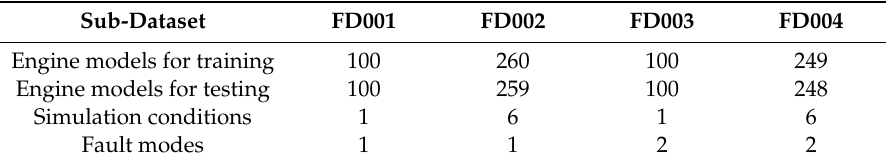
Table 2. Information of NASA C-MAPSS dataset.